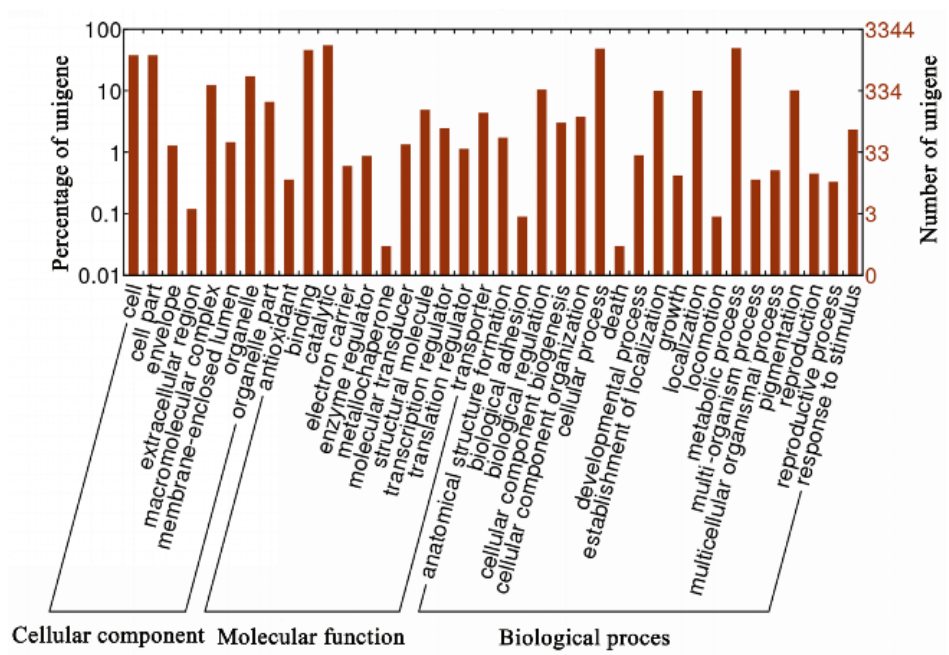
Figure 1. Functional annotations of the unigenes of Mortierella alpina based on the Gene Ontology (GO) analysis.